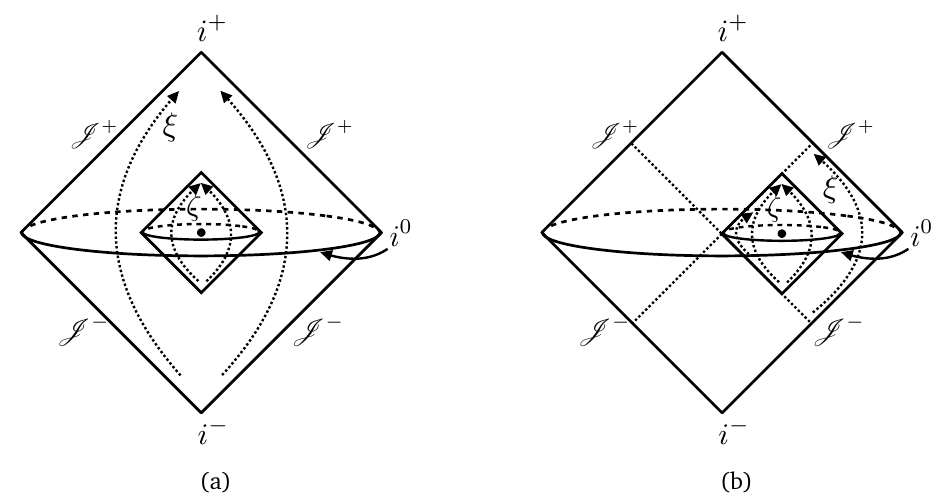
Figure 4: (a) A causal diamond associated to a ball at the center of Minkowski space. If one the normalizes the conformal Killing vector that preserves the diamond such that ζ 2 = − 1 at the center of the ball, then it becomes identical to the timelike Killing vector ξ = ∂ infinite-size limit. (b) A causal diamond whose edge touches the bifurcation surface of two Rindler horizons in Minkowski space. In the infinite-size limit the diamond coincides with the right Rindler wedge, and the conformal Killing vector ζ becomes the boost Killing vector ξ